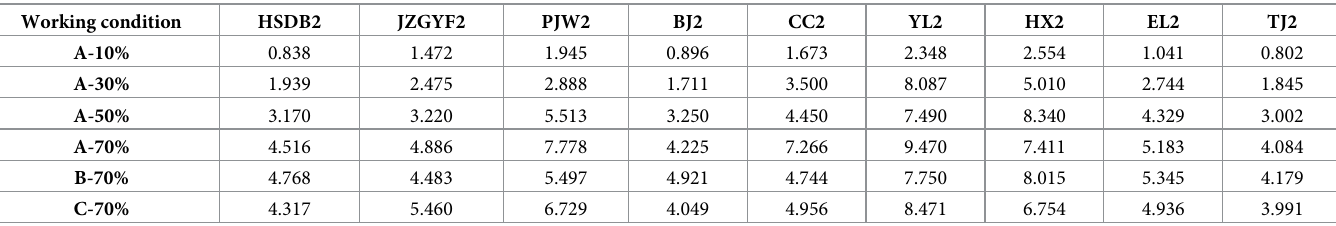
Table 15. The maximum hydrodynamic pressure P WD , 2 of the whole tank under bi-directional seismic motions with 1.0 m/s 2 peak acceleration (KPa). Working condition